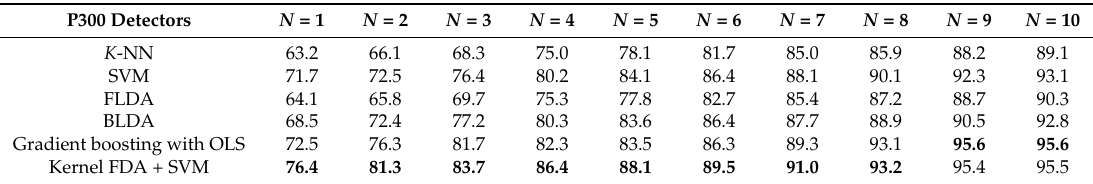
Table 5. Comparisons of average classification accuracy between different P300 detectors (in